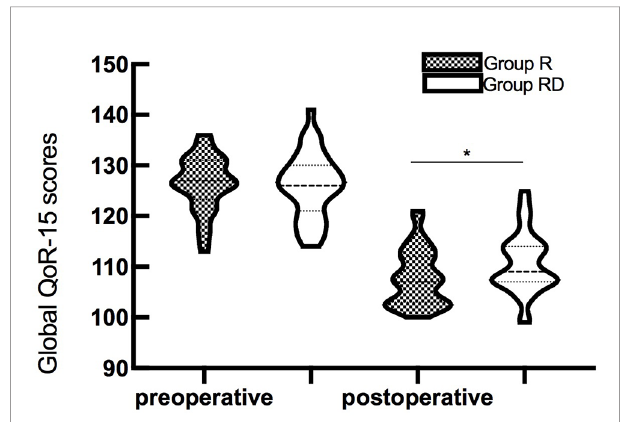
FIGURE 2 | Violin plots of the global QoR-15 scores (73 patients) before surgery and 24 h after surgery. The global QoR-15 scores in the group RD were higher than those in the group R (median difference: 4, 95% CI 1 – 6, p=0.016 by the Mann – Whitney U-test).